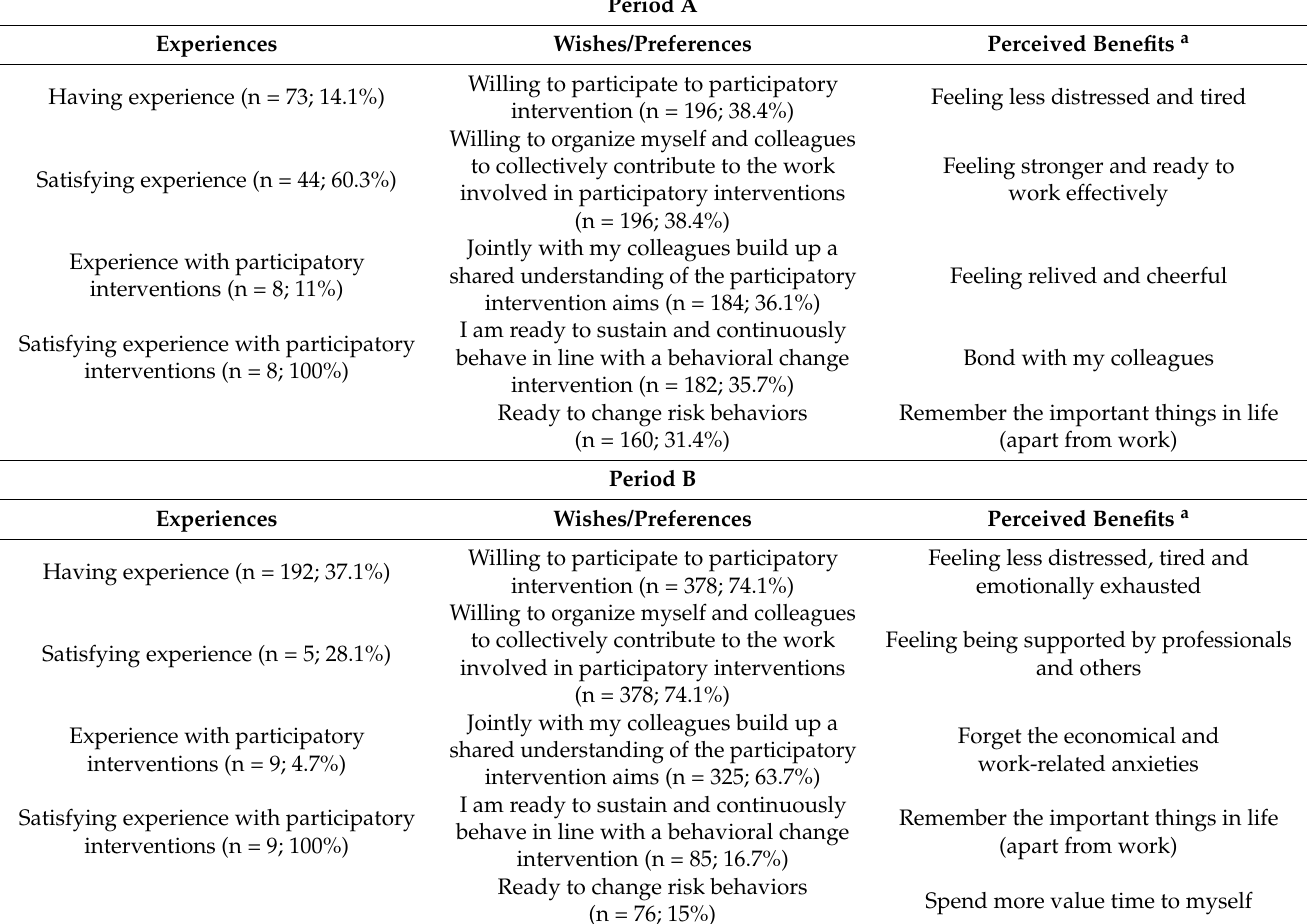
Table 3. Experiences, wishes/preferences and perceived benefits on mental health support services and participatory interventions before (n = 518) and during (n = 518) the financial crisis. Period